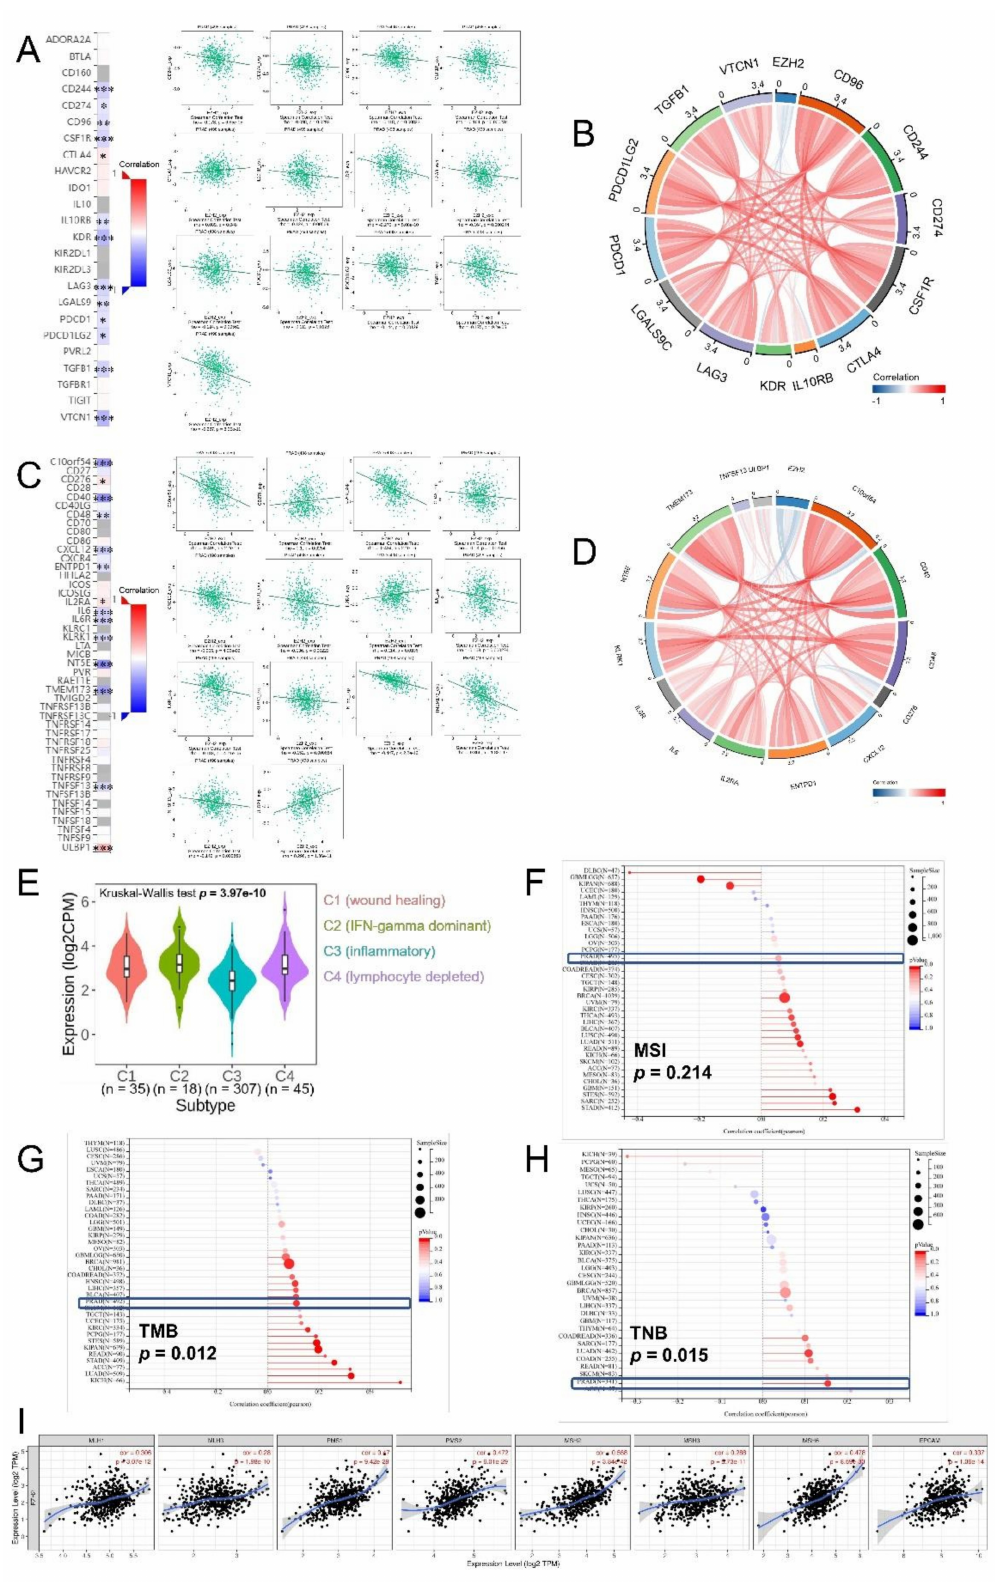
Figure 9. Correlations between EZH2 expression level and ( A , B ) immuno-inhibitor genes, ( C , D ) immuno-stimulator genes, ( E ) immune subtypes, ( F ) MSI, ( G ) TMB, ( H ) TNB, and ( I ) MMR genes. No significance, p -values < 0.05, 0.01, and 0.001 were presented as “ns”, “*”, “**”, and “***”,